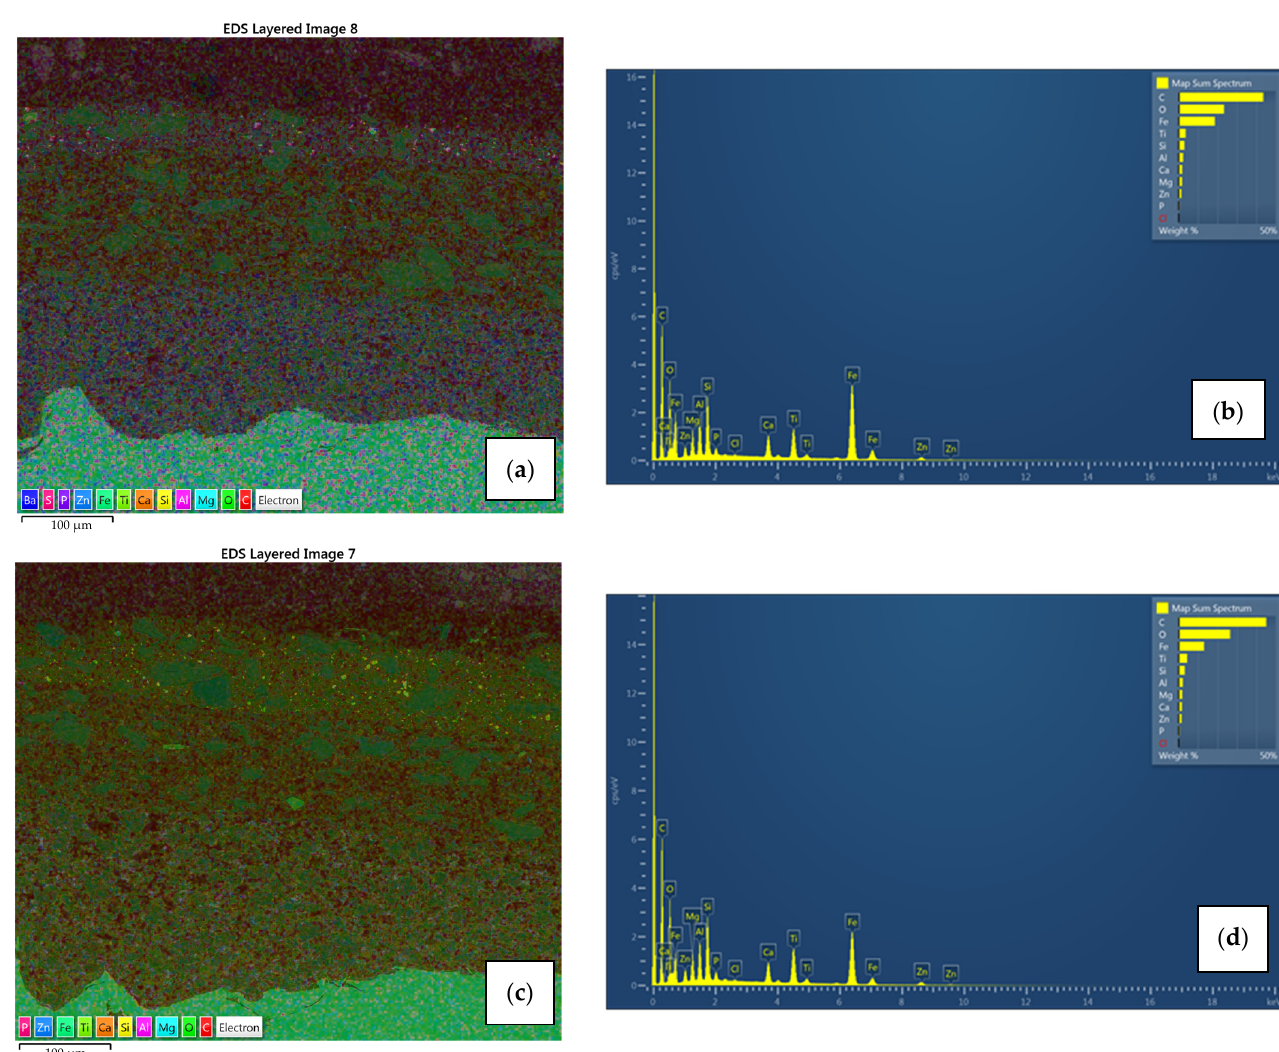
Figure 13. EDX spectroscopy and its elemental mapping for air-dried sample B1 (a, b) and IR-dried sample B2 (c, d) with distribution for each element. Ti uniformly scattered both in the primer and in the topcoat, Ca spread across the intermediate layer with Mg-Si-O inclusions, Zn and P in the primer due to zinc-phosphate pigment.